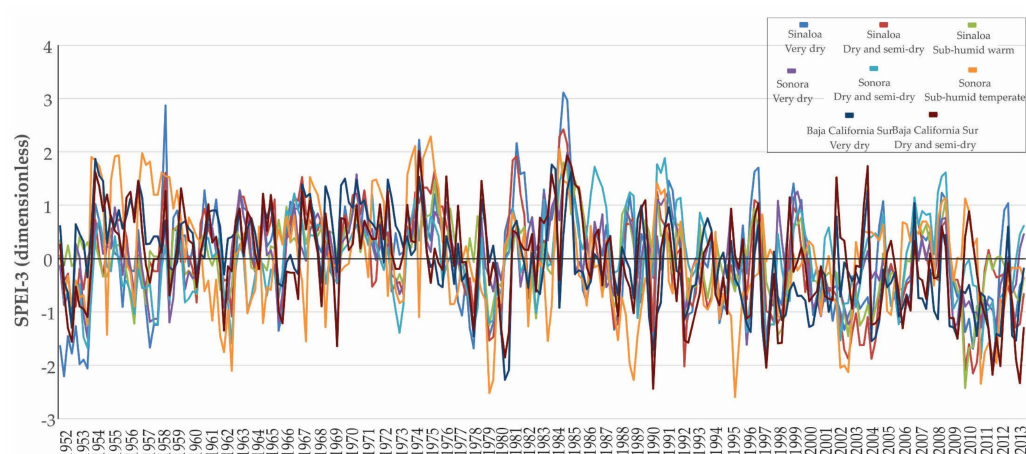
Figure 3. Seasonal variation of SPEI-3 by climate region in states in northern Mexico (Sinaloa, Sonora and Baja California Sur) in the period 1952–2013 (dimensionless). Source: Authors, following SPEI database (http://sac.csic.es/spei/) and INEGI climatic classification (http://www.cuentame.inegi.org.